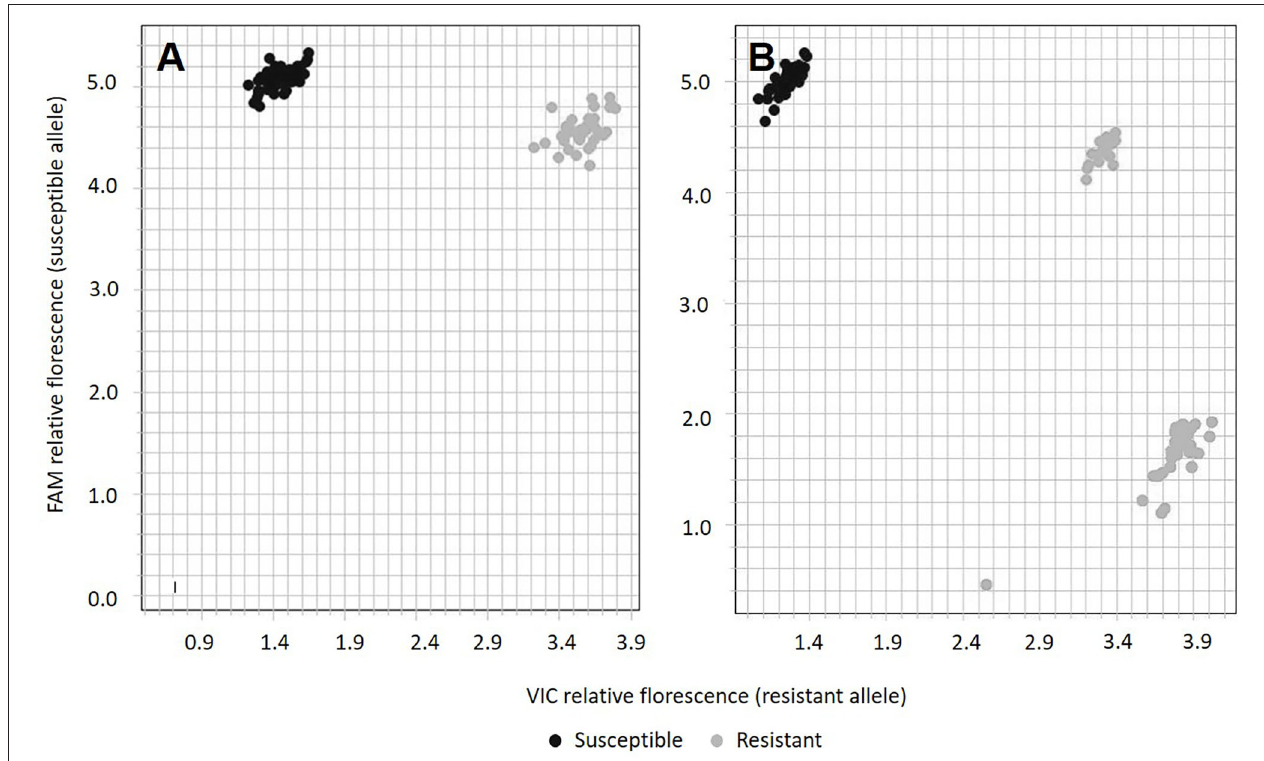
FIGURE 4 | Allelic discrimination plot from SNP assay PM_LH3804 using (A) the parents and 89 F1 progeny from “PNW39” × “Jumping Jack” and (B) 96 F1 progeny from “PNW39” × “Dwy1337.” Black dots represent individuals with the susceptible phenotype and gray dots represent individuals with the resistant phenotype.